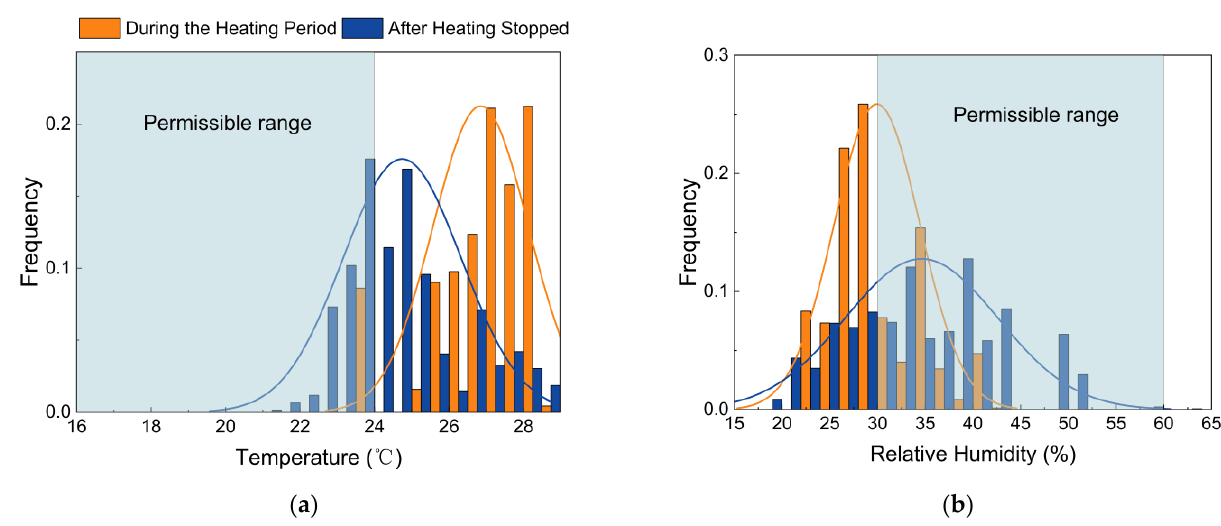
Figure 2. Histograms of thermal environmental parameters: ( a ) temperature; ( b ) RH.